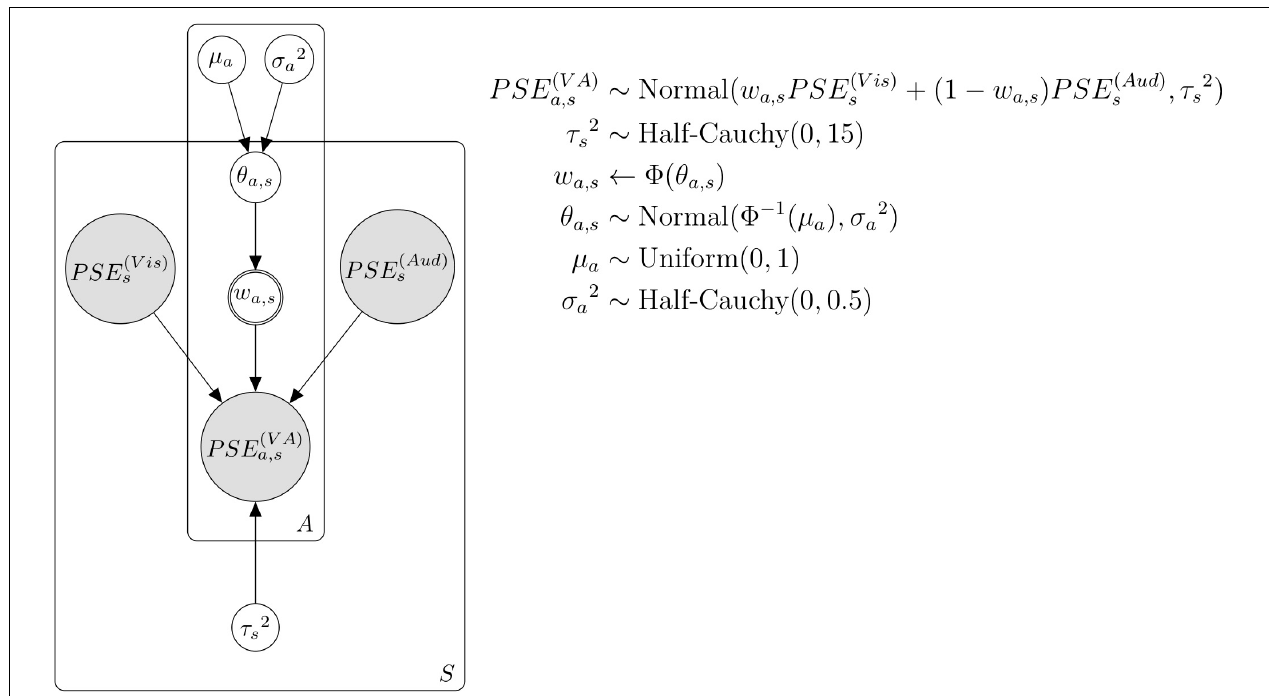
FIGURE 3 | Bayesian hierarchical model with the weight by attention. A and a represent each attention condition. S and s represent each